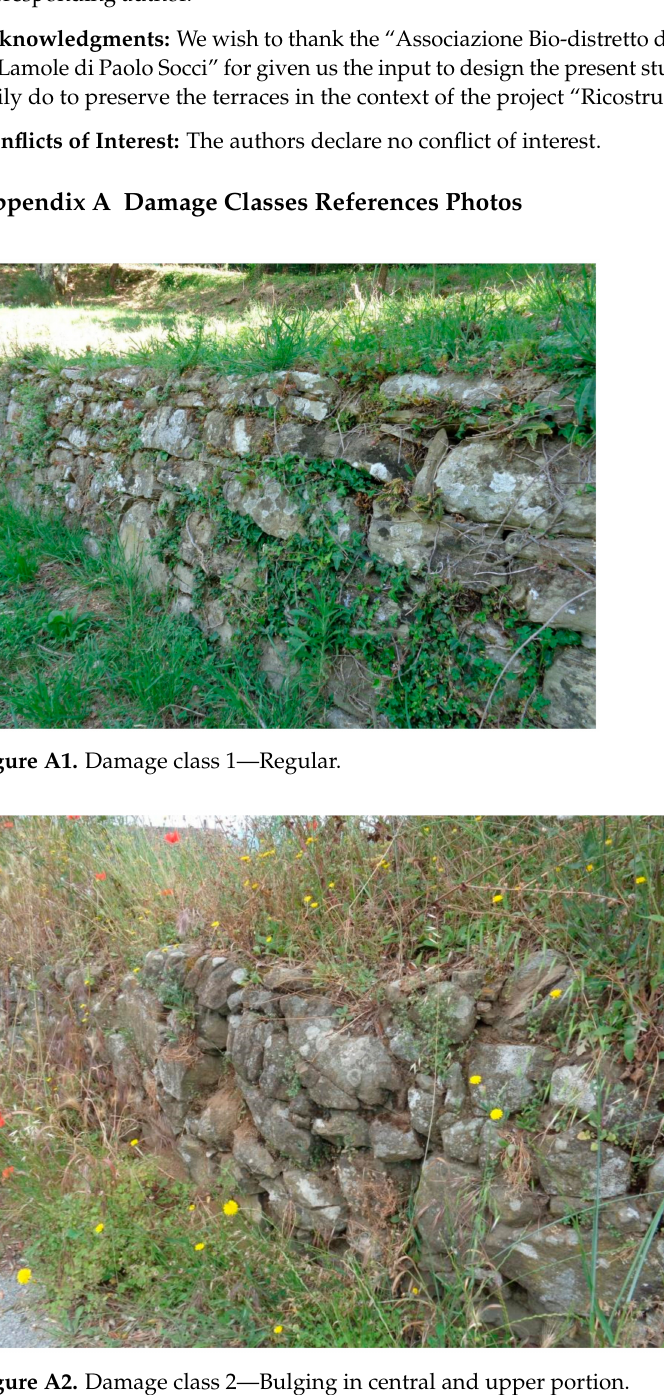
Figure A2. Damage class 2—Bulging in central and upper